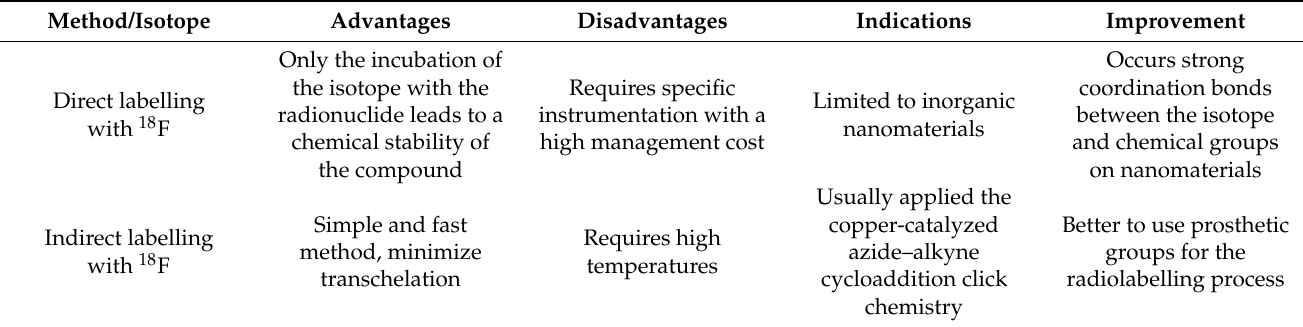
Table 5. Pros and cons of different methods for radiolabelling NPs with